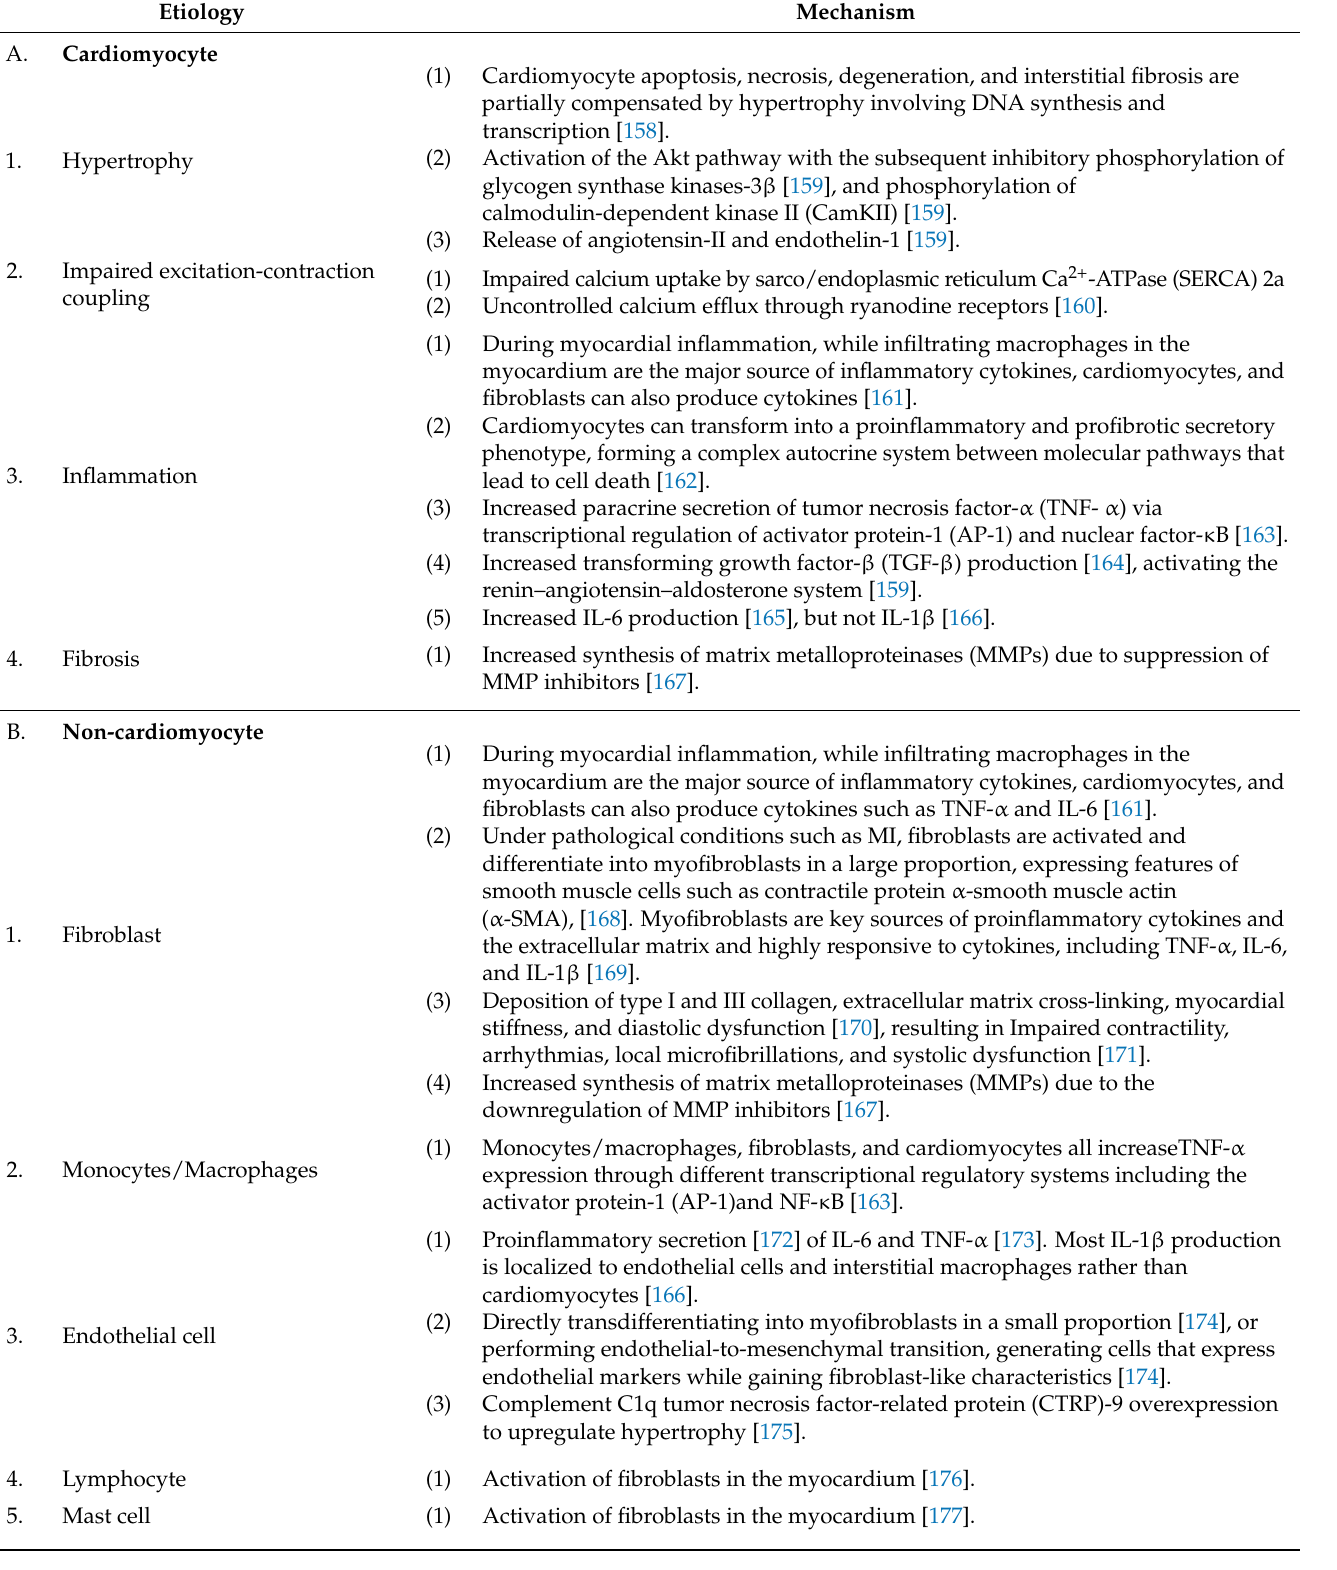
Table 1. Proposed mechanisms of coronary artery spasm-related heart